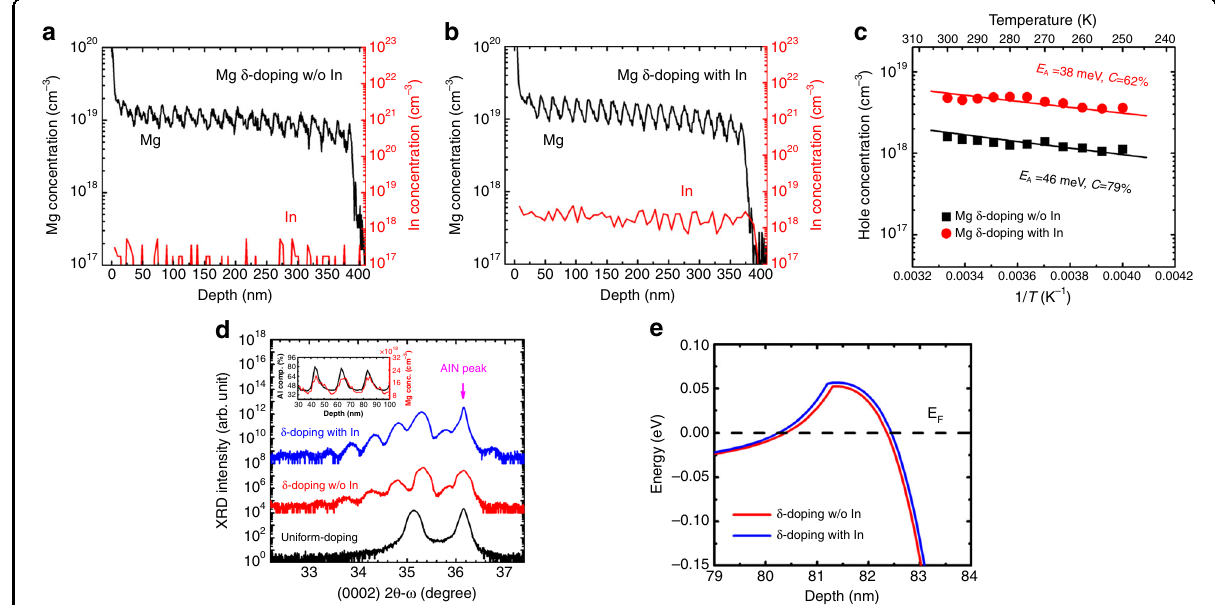
Fig. 7 Mg- δ -doped AlGaN layers with and without In surfactant. a , b Mg and In concentration depth pro fi les. c Temperature-dependent hole concentrations. The solid lines are fi tting curves. d HRXRD (0002) 2 θ - ω scan curves. The inset presents the Al-content and Mg concentration depth pro fi les in the In-surfactant-assisted sample. e Calculated self-consistent valence band diagrams at the quantum-well and graded-barrier interface, as a result of Mg- δ -doping. Reprinted with permission from Jiang et al. 76 . Copyright 2015 AIP Publishing